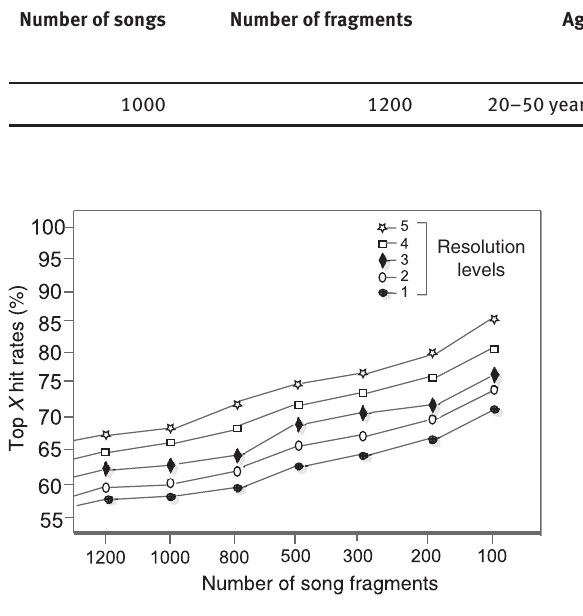
Figure 5. Top X Hit Rate